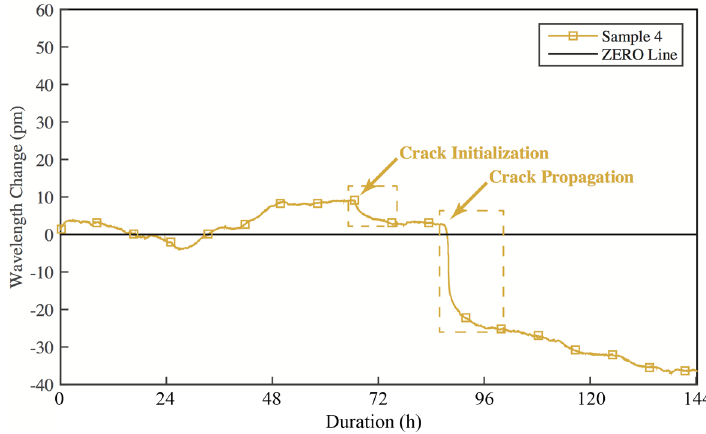
Figure 20. Bragg wavelength change Sample #4 to identify cracks in coating.